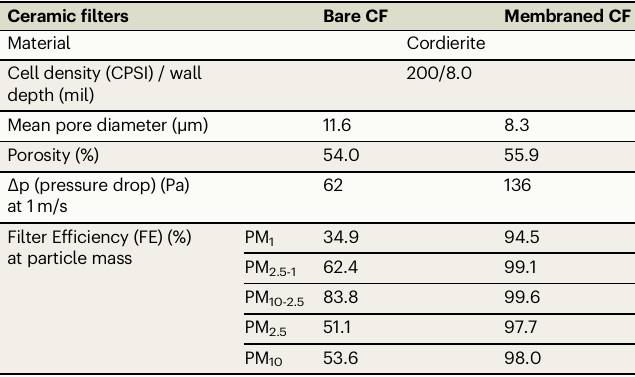
Table 1 | Physical properties and measuring data: pressure drop and PM removal ef fi ciency of bare and membraned ceramic fi lters (at 115 mm) Ceramic fi lters Bare CF Membraned